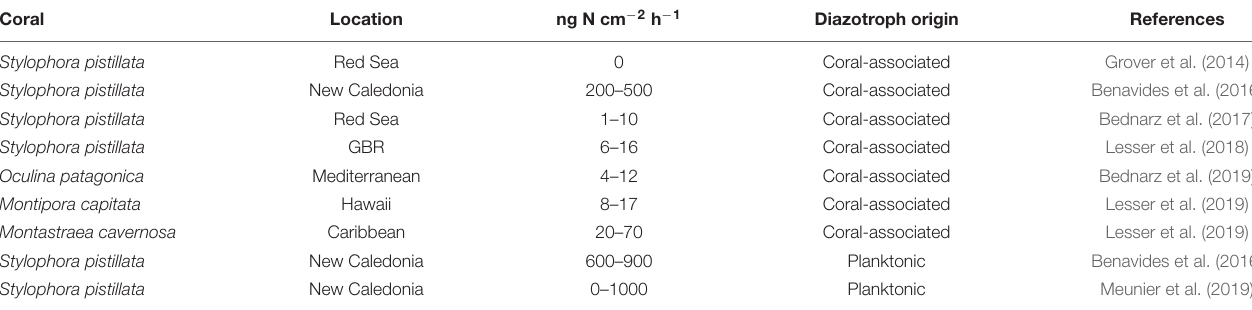
TABLE 1 | Overview of studies that quantified DDN assimilation in scleractinian corals using the 15 N 2 tracer